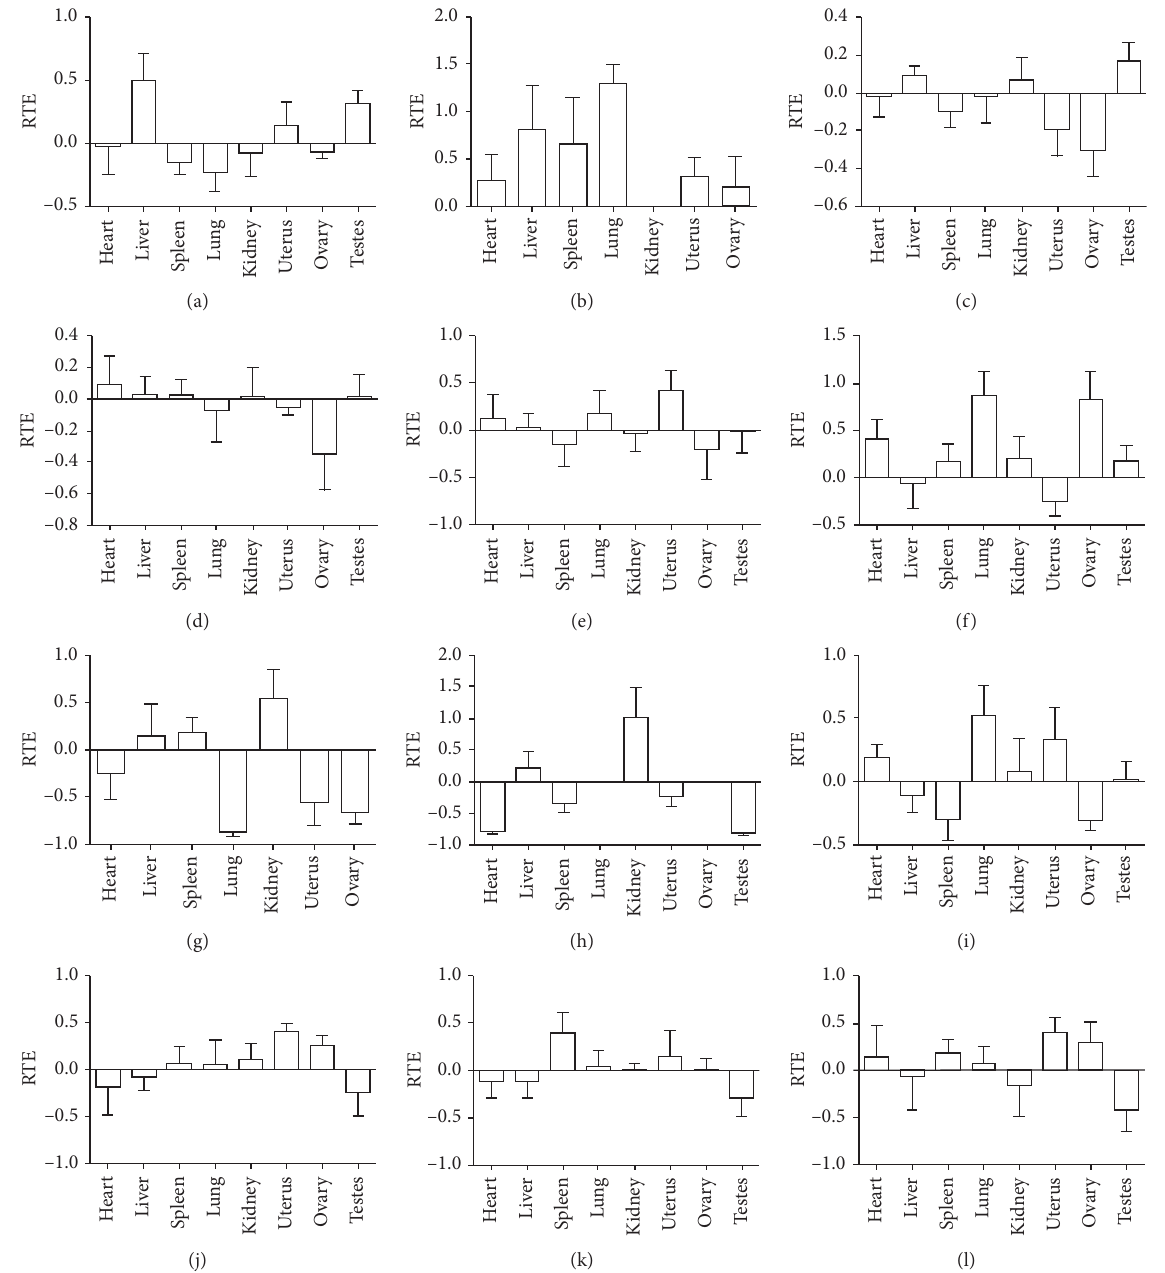
Figure 4: The RTE profiles of 12 kinds of compounds in crude and salt-processed Qing’e pills in rat tissue ( n � 3 for sexual organs and n � 6 for other tissues). (a) Geniposidic acid, (b) pinoresinol diglucoside, (c) psoralen, (d) isopsoralen, (e) psoralenoside, (f) bavachin, (g) isobavachin, (h) bavachalcone, (i) isobavachalcone, (j) neobavaisoflavone, (k) psoralidin, and (l) tissues, and there was no significant change in the distribution after salt-processing ( p > 0 . 05). RTE indicates the proportion of drug distribution of the salt-processed product relative to the crude product. RTE > 0 indicates that the component of the salt-processed product enters the tissue. The larger the RTE, the more effective the targeting effect. The RTE of 12 components is shown in Figure 4. The target of geniposidic acid was the liver (0.50), testes (0.32), and uterus (0.14). The target of pinoresinol